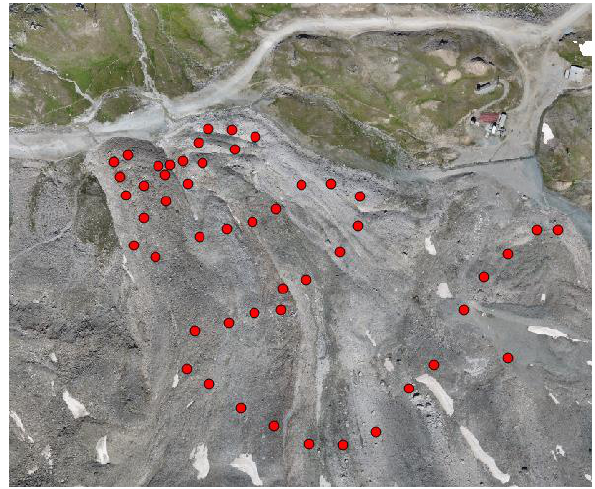
Figure 3: Localization of the 48 GNSS measured points.